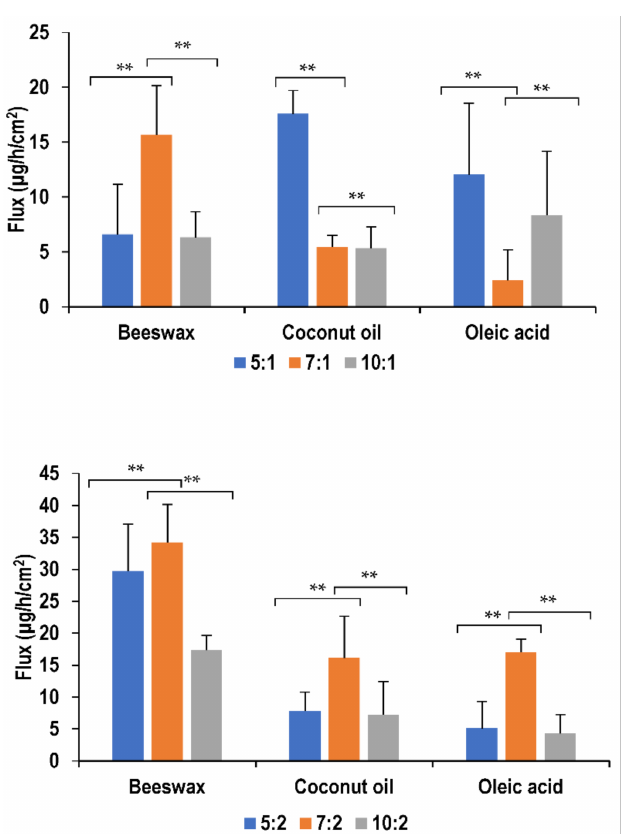
Figure 9. Effect of surfactant and oil concentration on flux of lidocaine nanoemulsion through pig skin membrane (** p >